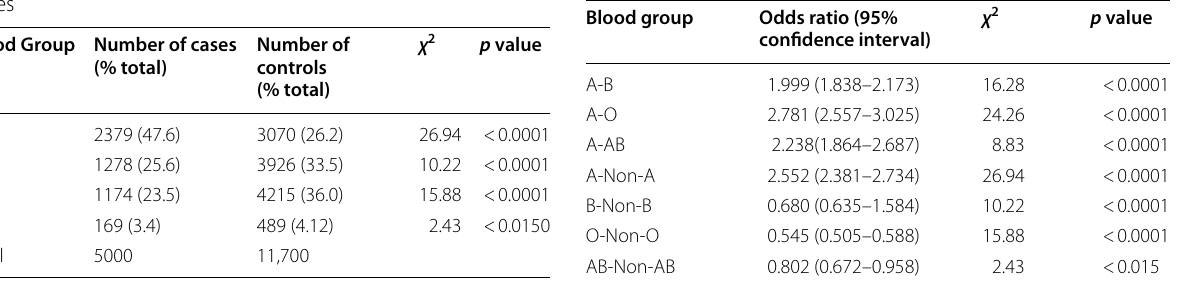
Table 2 Comparison of ABO blood group